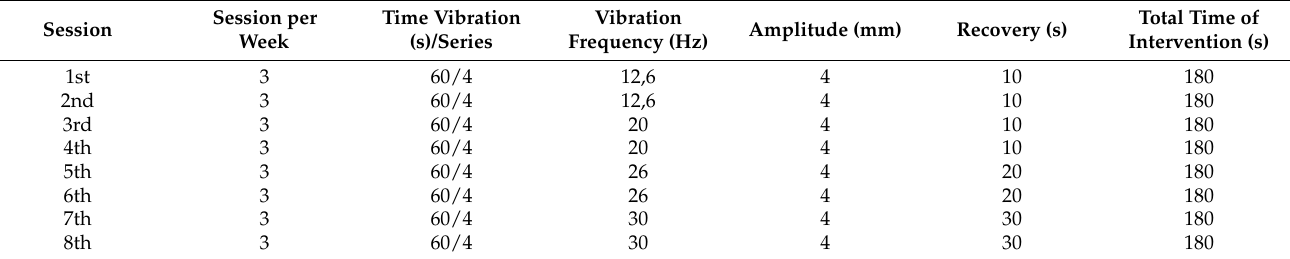
Table 2. Protocol of the vibratory platform